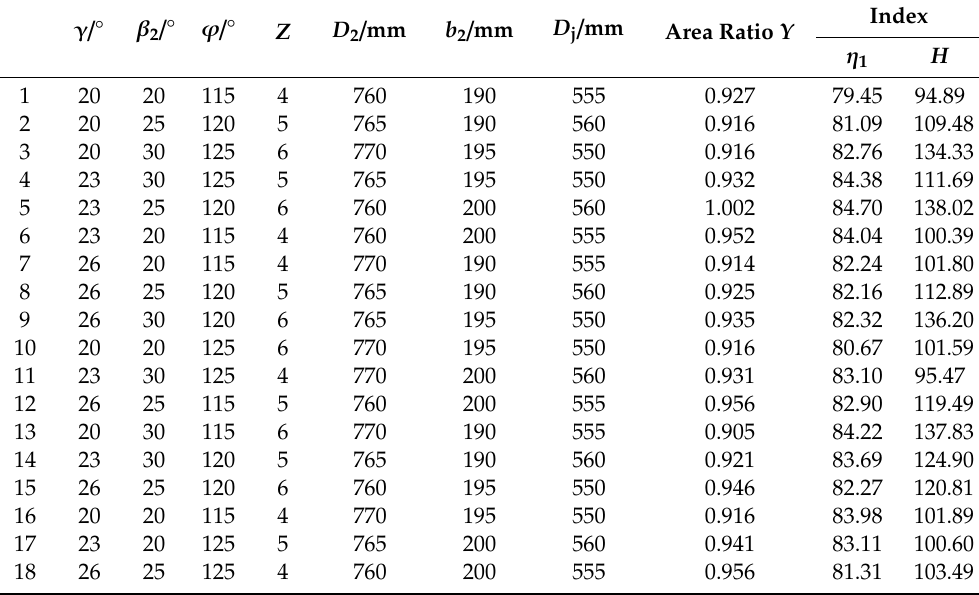
Table 1. Test scheme and performance calculation